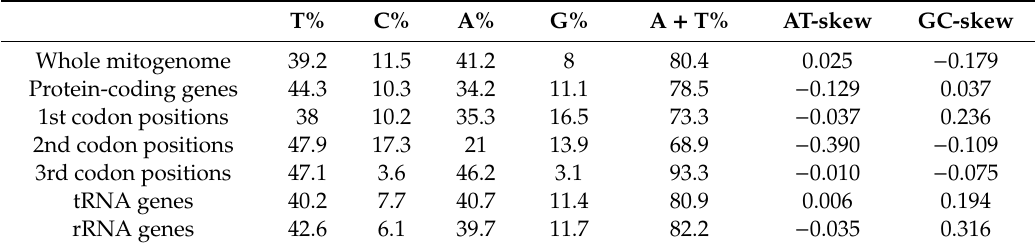
Table 3. Nucleotide composition of the Amara aulica mitochondrial